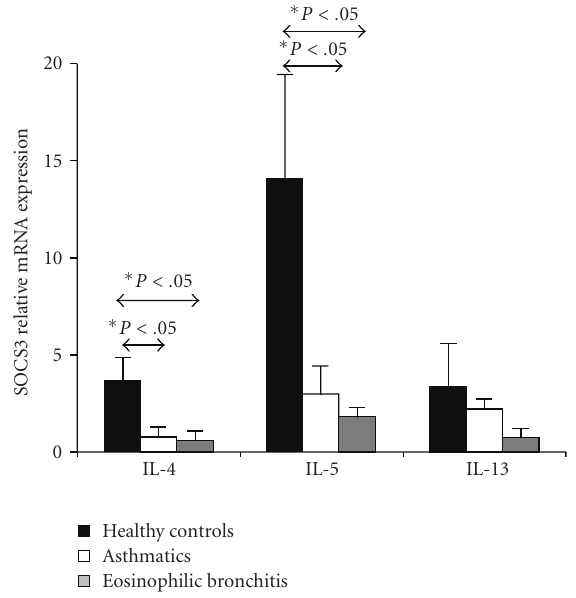
Figure 4: SOCS3 mRNA expression in Th2-stimulated eosinophils from healthy controls, asthmatics, and NAEB patients. Eosinophils from healthy controls, asthmatics,and NAEB patients were cultured with 10ng/mL of IL-4 or IL-5, or IL-13 during 60min. SOCS3 mRNA was measured by real-time quantitative PCR. The results are expressed as a fold induction relative to untreated eosinophils, and significant di ff erences are indicated. Data represent the geometric mean ± SD from three individuals, and each measure was performed in